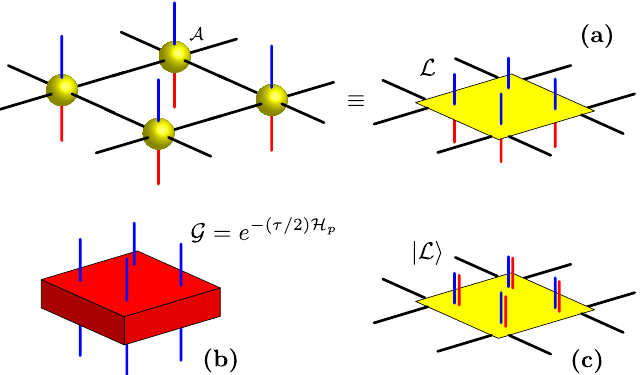
Figure 3: (a) Elementary plaquette representation of the (half-) density operator L . (b) Plaquette gate G . (c) The L iPEPO operator can be viewed as a purified PEPS | L 〉 .